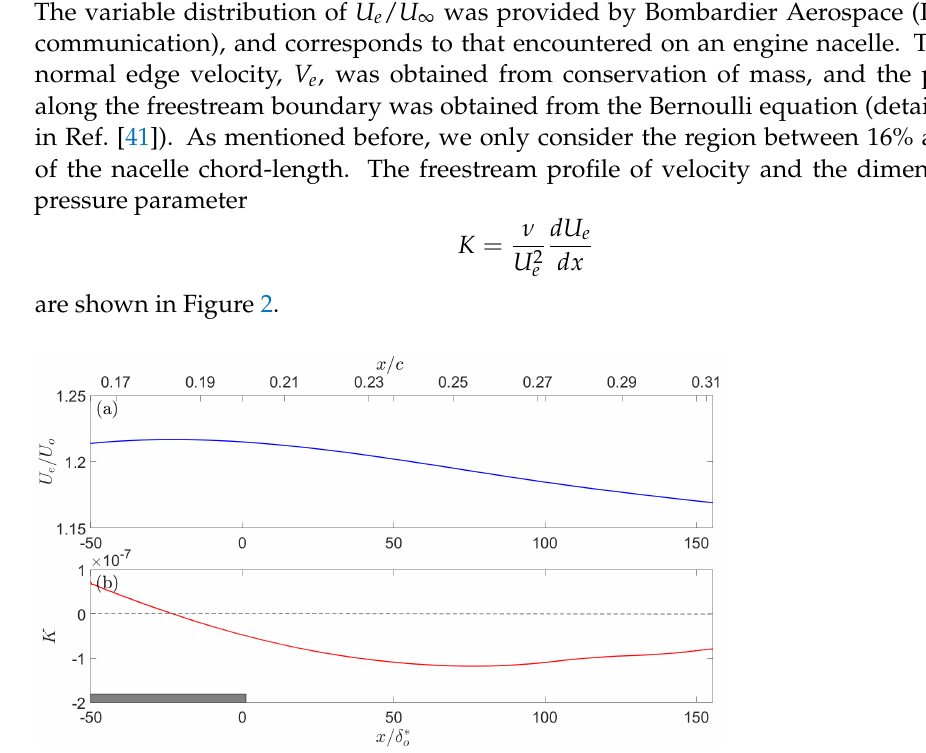
Figure 2. Freestream profiles of ( a ) velocity, U e / U ∞ and ( b ) pressure gradient, K ; the top axis is in chord length unit, x / c . The grey area shows the position of the